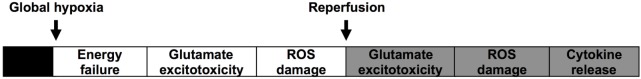
Illustrates the commonly accepted hypothesis for the two waves of energy failure and injury in the brain after asphyxia at birth.